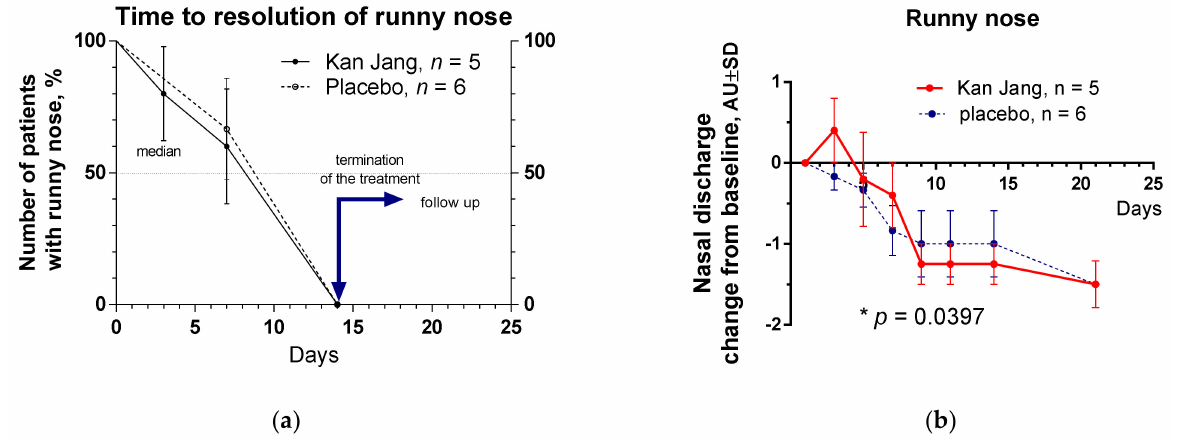
Figure 5. ( a ) Time to resolution of runny nose in the treatment and control groups: Kaplan–Meier curves show the percent of patients with runny nose over the time from randomization (Day 1) to the end of the treatment (Day 14) and follow up for one week (Day 21) and in the treatment and control groups; median recovery: Kan Jang ® , was 14 days, placebo was 14 days; hazard ratio Kan Jang/placebo = 1.534, 95% CI of ratio from 0.17 to 13.57. ( b ) Reduction in nasal discharge; the changes in the severity of the symptom from the baseline of patients in group A (Kan Jang) and group B (placebo) over the time from Day 1 to Day 21. Between-groups comparison of the changes in the severity of the symptom from the baseline over time shows significant interaction ( p = 0.0397). The Kan Jang ® treatment has a statistically significant effect on the reduction in nasal discharge compared to the placebo. * p <